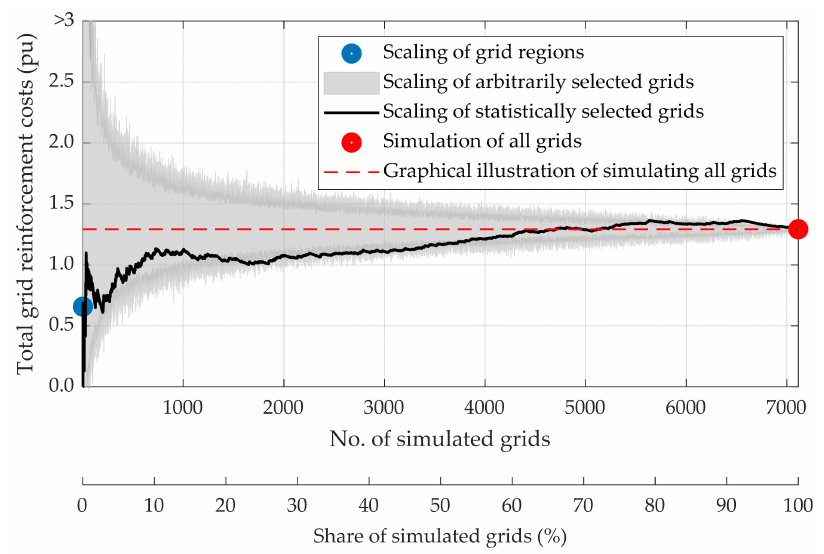
Figure 8. Comparison of different quantification methods regarding their detected total grid rein- forcement costs depending on their number and share of simulated